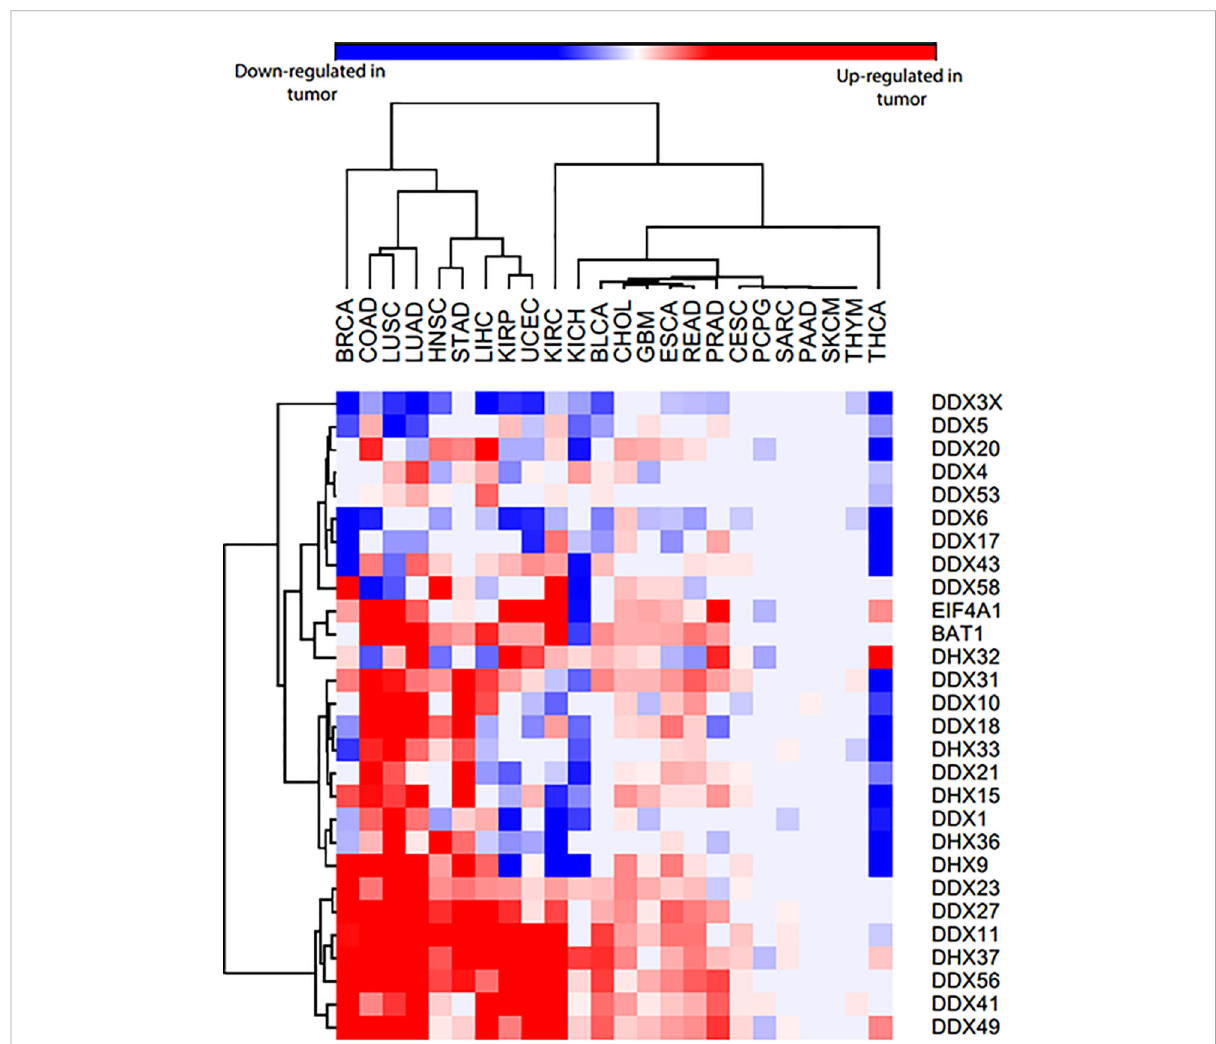
FIGURE 2 Heatmap of DEAD/H-box helicases expression in 24 different cancers and normal tissues from TCGA patient data. The blue color represents that they are signi fi cantly lost in tumor samples compared to normal samples, red color represents that they are signi fi cantly overexpressed in tumor samples compared to normal samples, and grey means no signi fi cant difference between normal and tumor samples. Cancer type abbreviations used are: BRCA, Breast invasive carcinoma; COAD, Colon adenocarcinoma; LUSC, Lung squamous cell carcinoma; LUAD, Liver hepatocellular carcinoma; HNSC, Head and neck squamous cell carcinoma; STAD, Stomach adenocarcinoma; LIHC, Liver hepatocellular carcinoma; KIRP, Kidney renal papillary cell carcinoma; UCEC, Uterine corpus endometrial carcinoma; KIRC, Kidney renal clear cell carcinoma; KICH, Kidney Chromophobe; BLCA, Bladder urothelial carcinoma; CHOL, Cholangiocarcinoma; GBM, Glioblastoma multiforme; ESCA, Esophageal carcinoma; READ, Rectum adenocarcinoma; PRAD, Prostate adenocarcinoma; CESC, Cervical squamous cell carcinoma and endocervical adenocarcinoma; PCPG, Pheochromocytoma and paraganglioma; SARC, Sarcoma; PAAD, Pancreatic adenocarcinoma; SKCM, Skin cutaneous melanoma; THYM, Thymoma; THCA, Thyroid carcinoma. BAT1 is DDX39B and EIF4A1 is